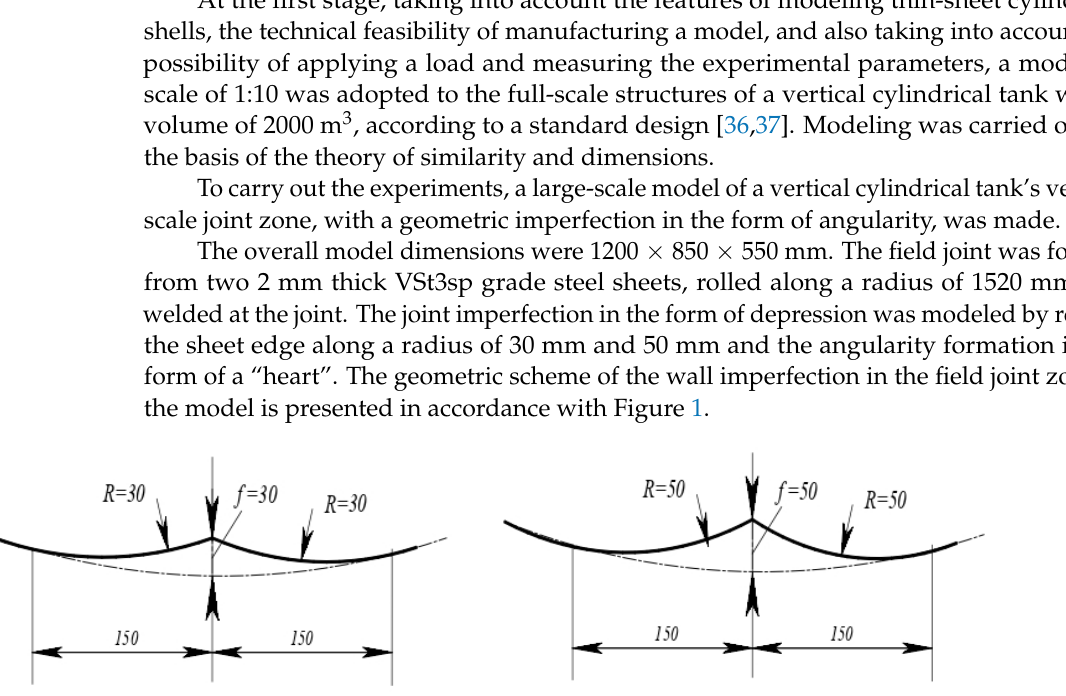
Figure 1. Geometric dimensions of the joint imperfection in the model.